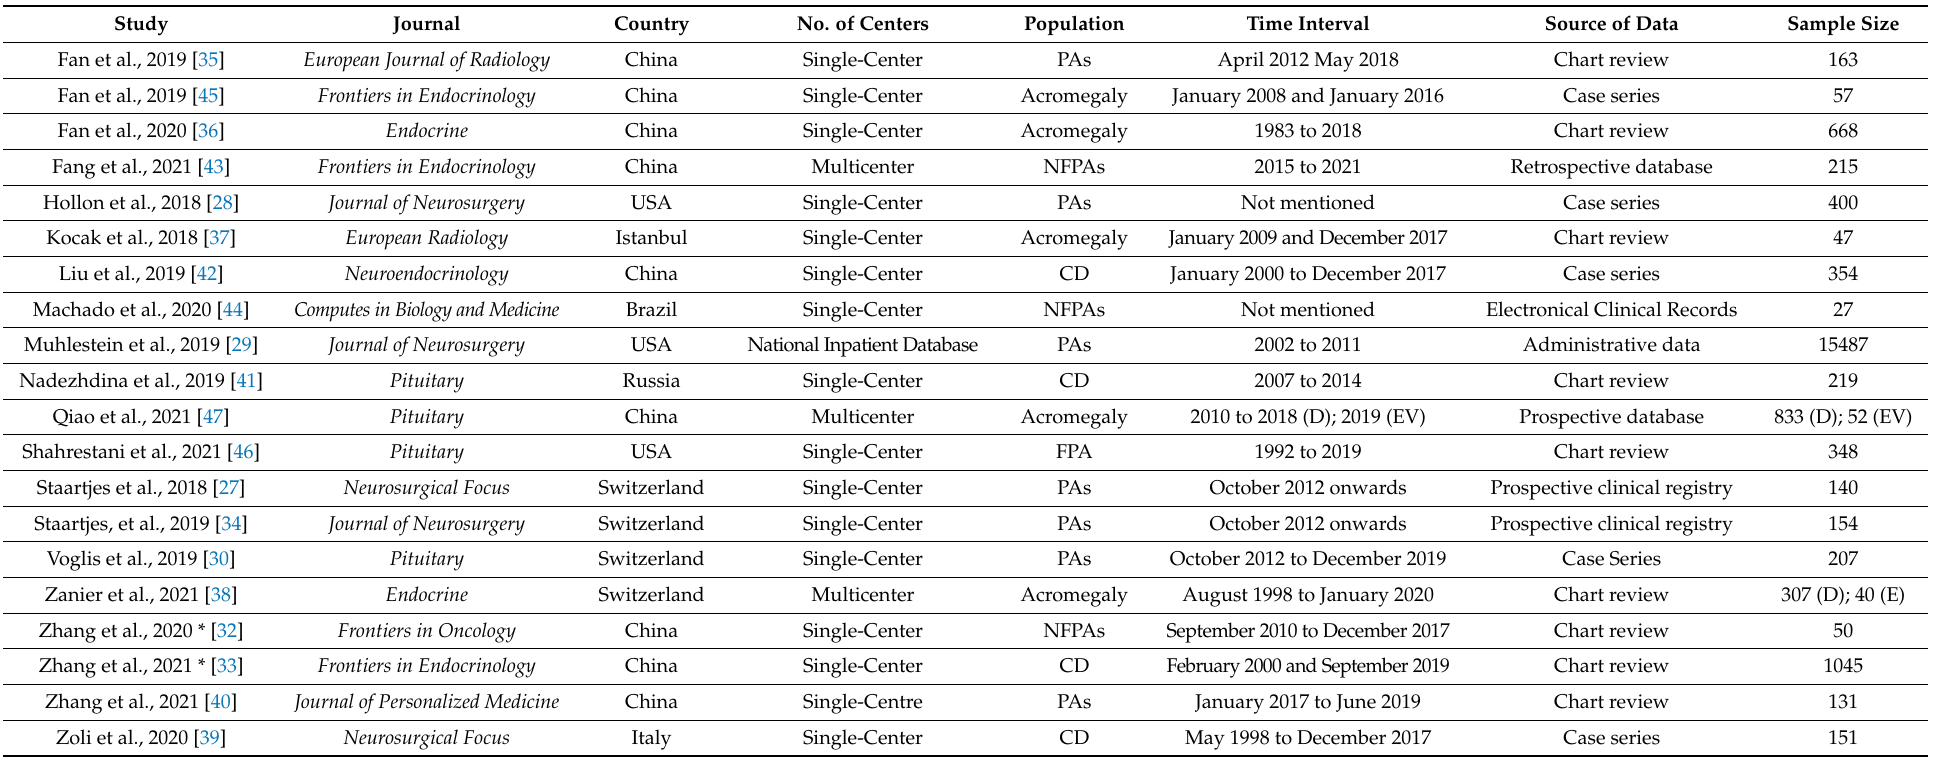
Table 3. Characteristics of included studies.